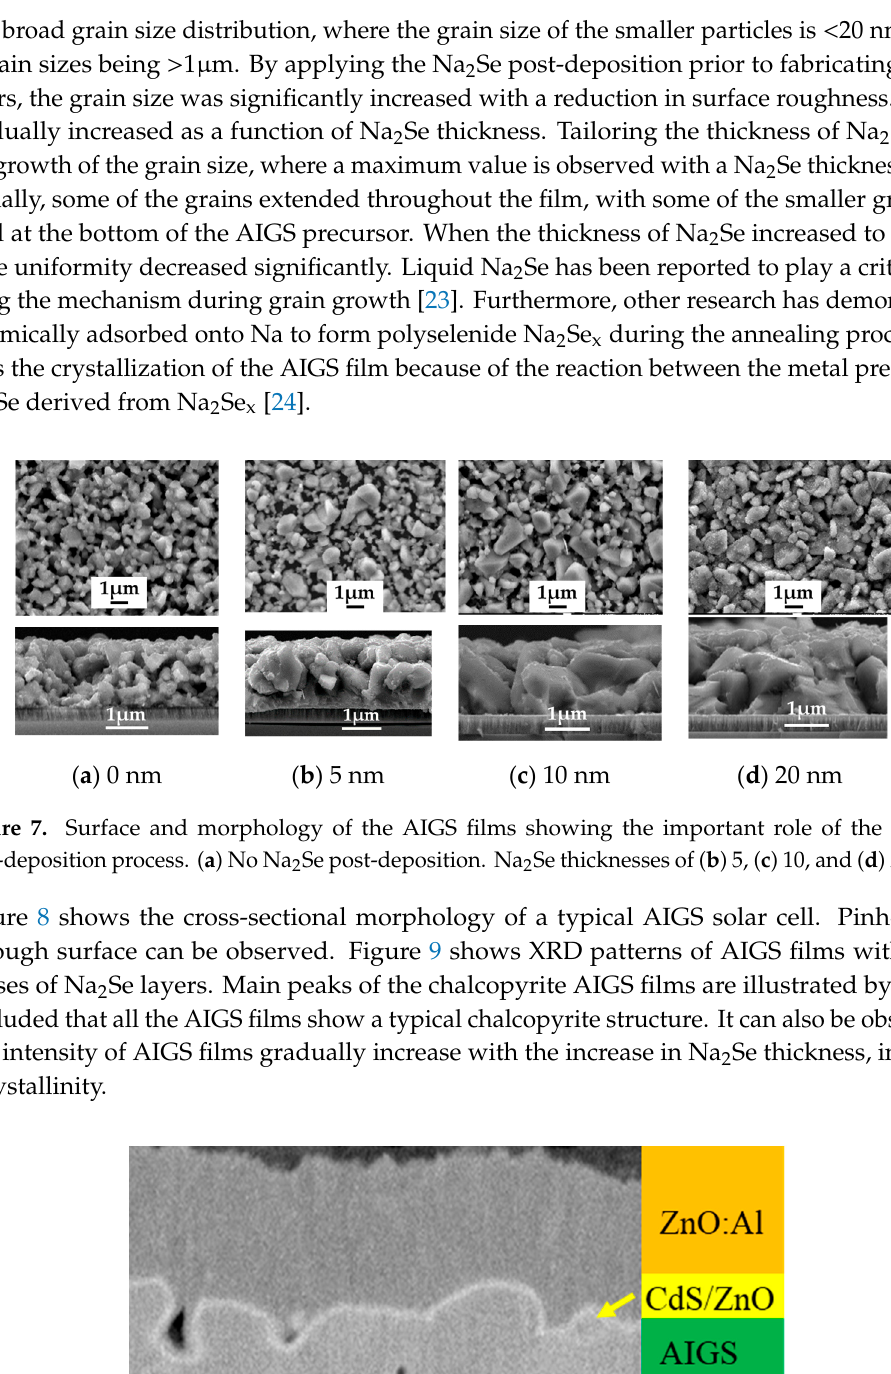
Figure 8. Cross-sectional SEM image of a typical AIGS solar cell.